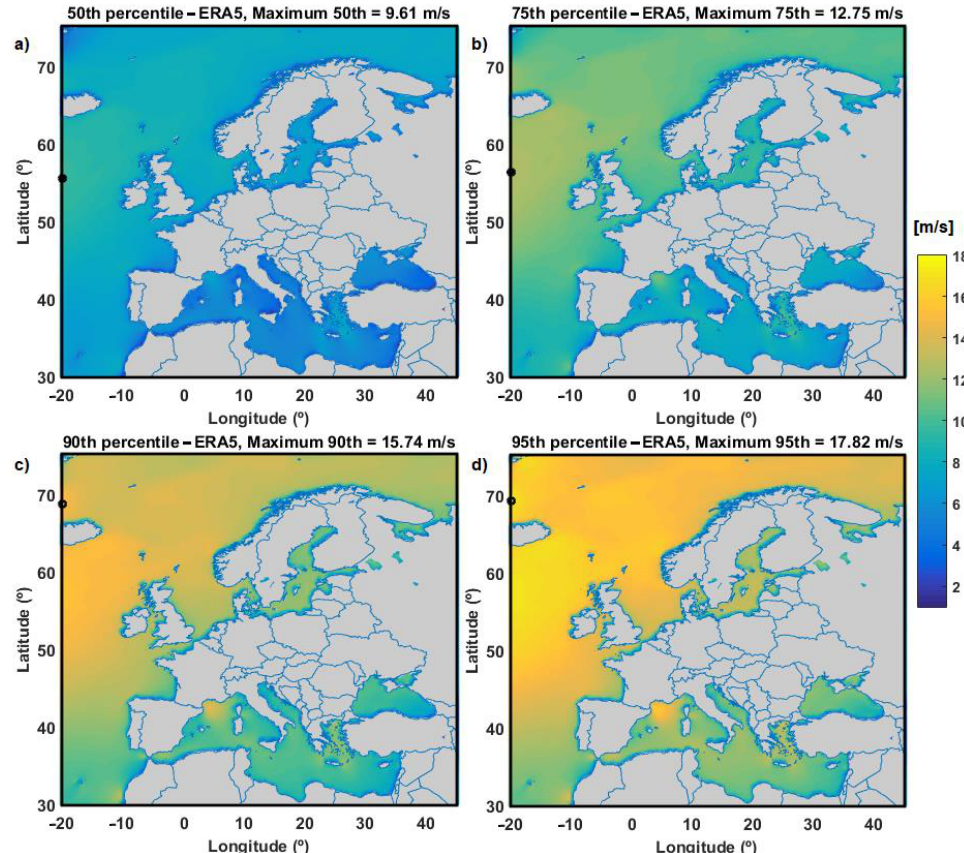
Figure 12. Statistical investigation on wind speed: ( a ) 50th percentile; ( b ) 75th percentile; ( c ) 90th percentile; ( d ) 95th percentile.